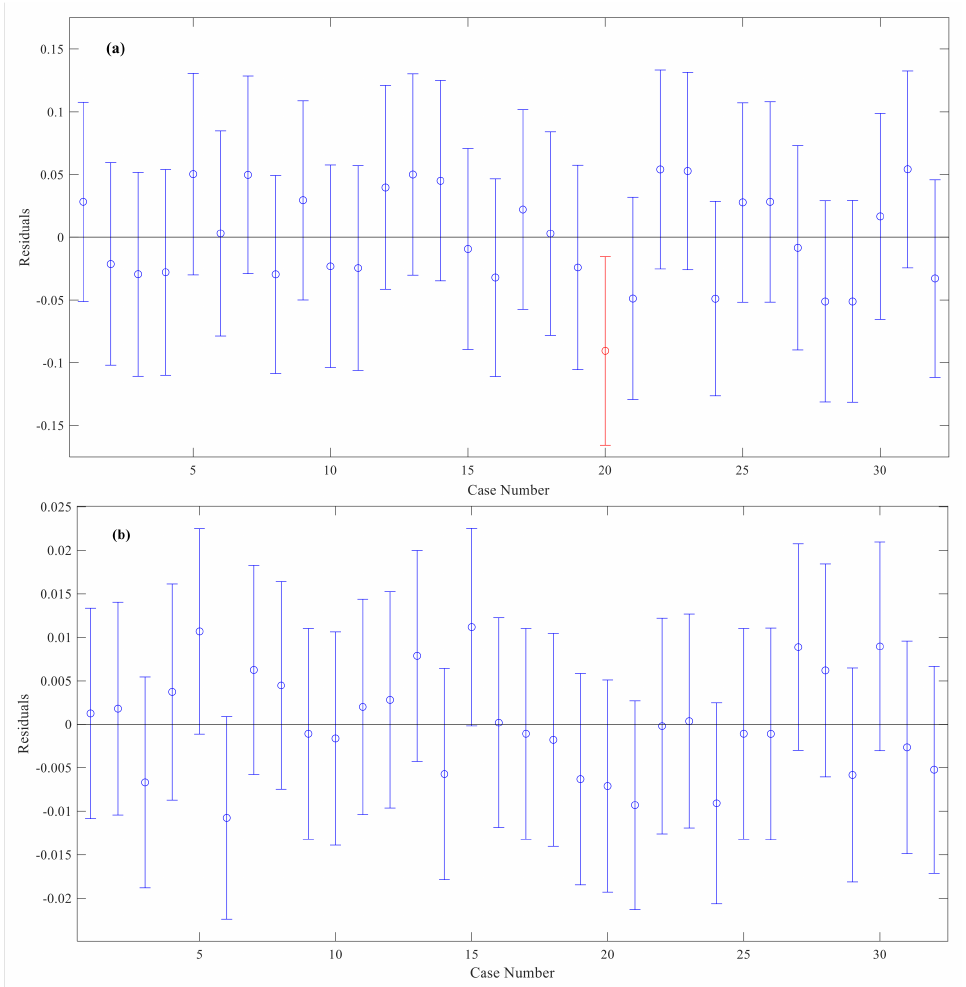
Figure 14. The residual plot of ( a ) normal and ( b ) information spread distributions for the V D < 0.1 µ m